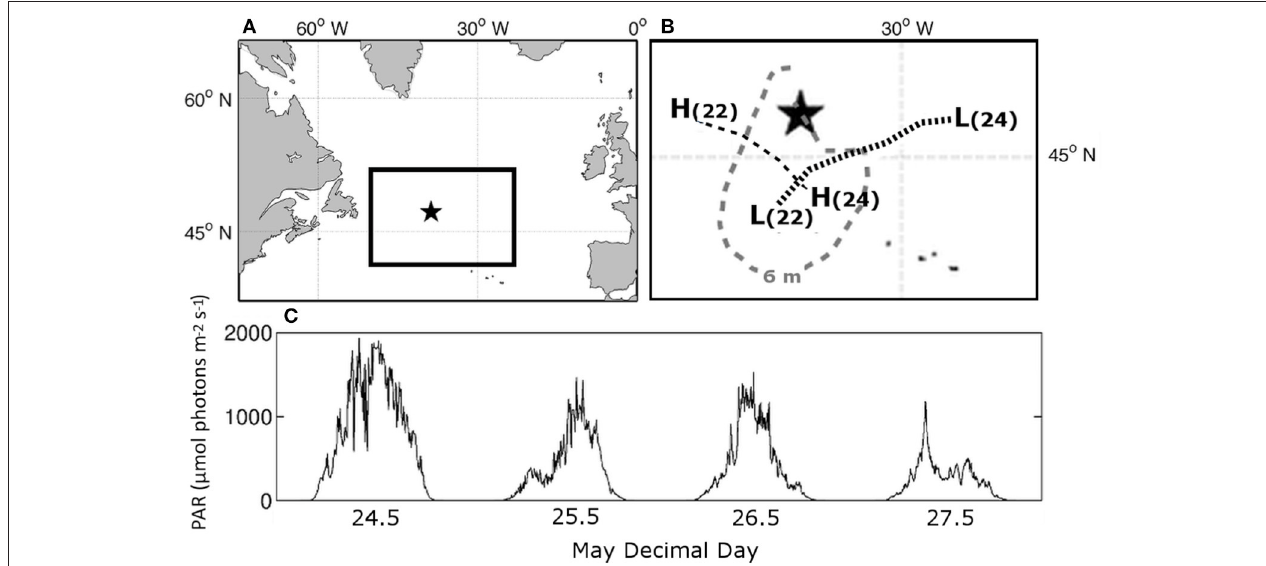
FIGURE 1 | (A) Location of station in the North Atlantic ocean, (B) track of low (L) and high (H) pressure systems on day 22 and 24 and the 6m wave height contour on May 22nd prior to our arrival on station on May 24. (C) Surface PAR during occupation of Station